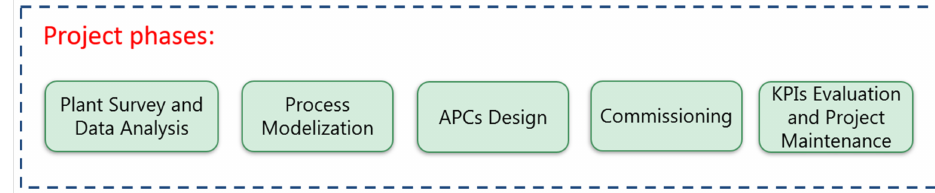
Figure 2. Project phases.